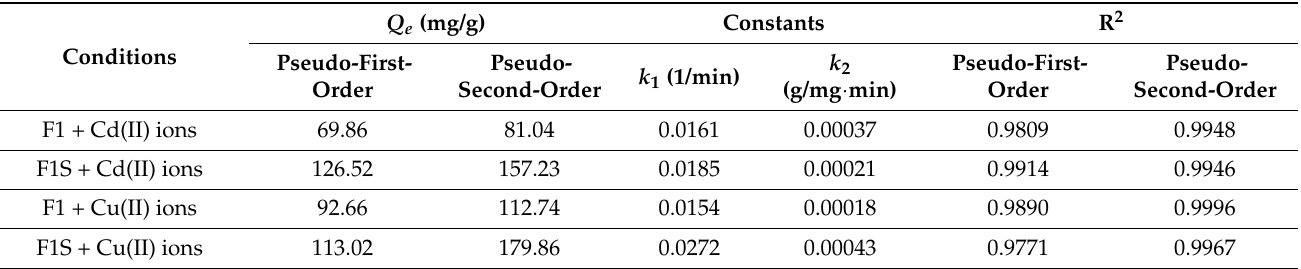
Table 3. The constants of the pseudo-first-order and pseudo-second-order kinetic models for the removal of copper and cadmium ions using the F1 and F1S samples.